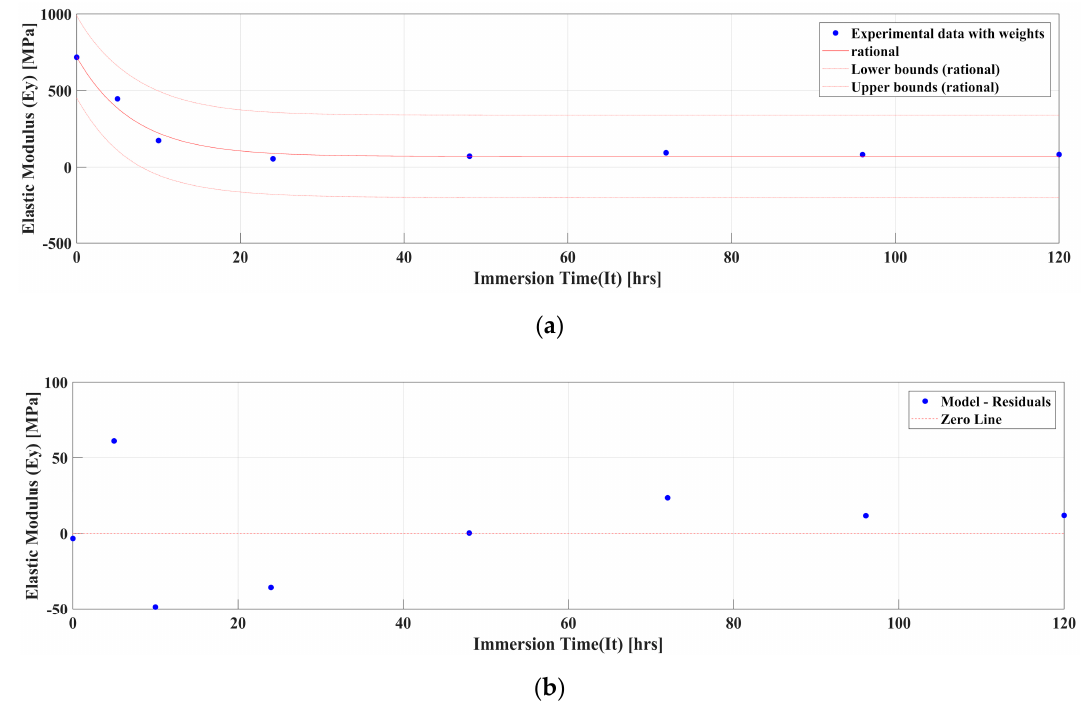
Figure 10. Graph of elastic modulus ( Ey ) for MM4520 for ( a ) fitted model and ( b ) residuals. Table 3. Estimated coefficients for MM4520 elastic modulus with respect to immersion time in water.